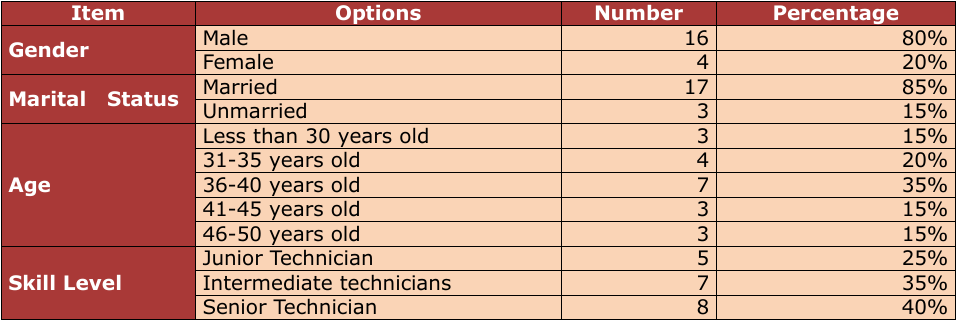
Table 1. Distribution characteristics of interview